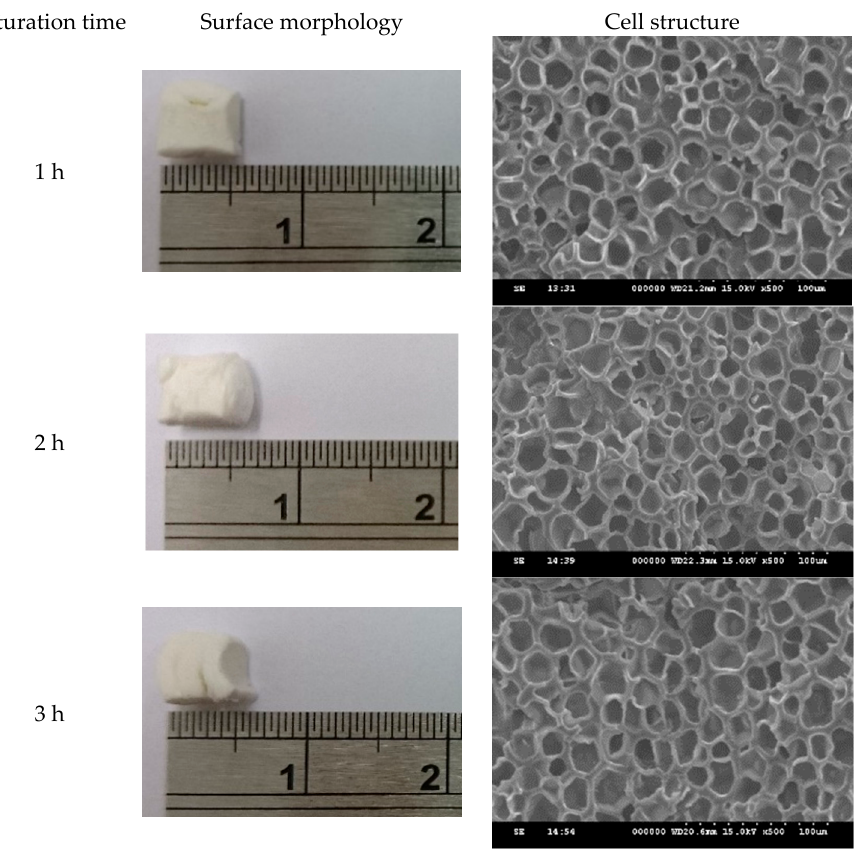
Figure 4. Comparison of surface morphology and cell structure of produced TPU foams from foaming experiments using saturation times of 1, 2 and 3 h.